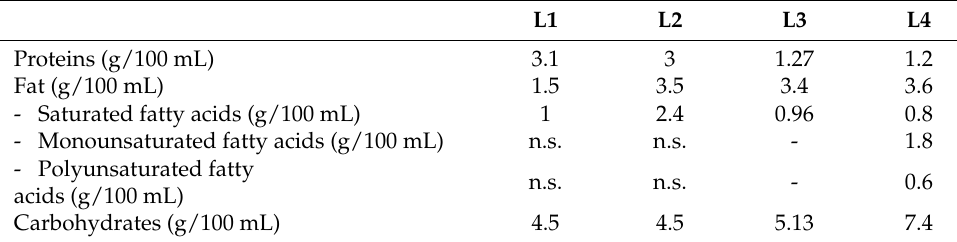
Table 1. Milk composition as declared by the